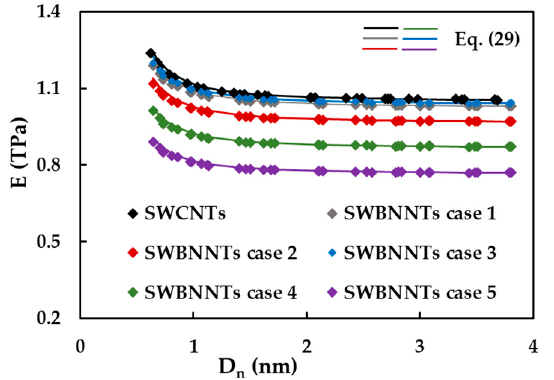
Figure 9. The evolution of the Young’s modulus, E, with the nanotube diameter, D n , for SWBNNTs and SWCNTs.